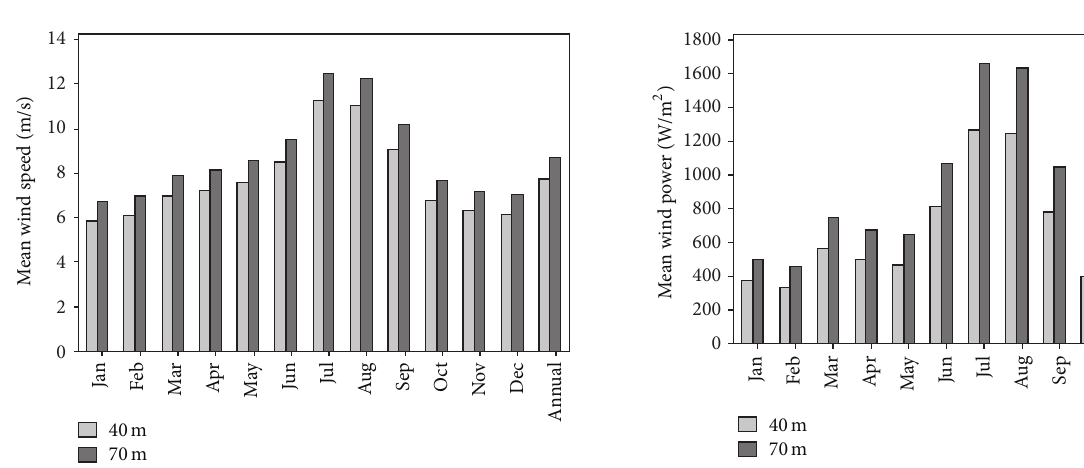
Figure 4: Monthly and annual mean wind power (W/m 2 ) at 40 and 70